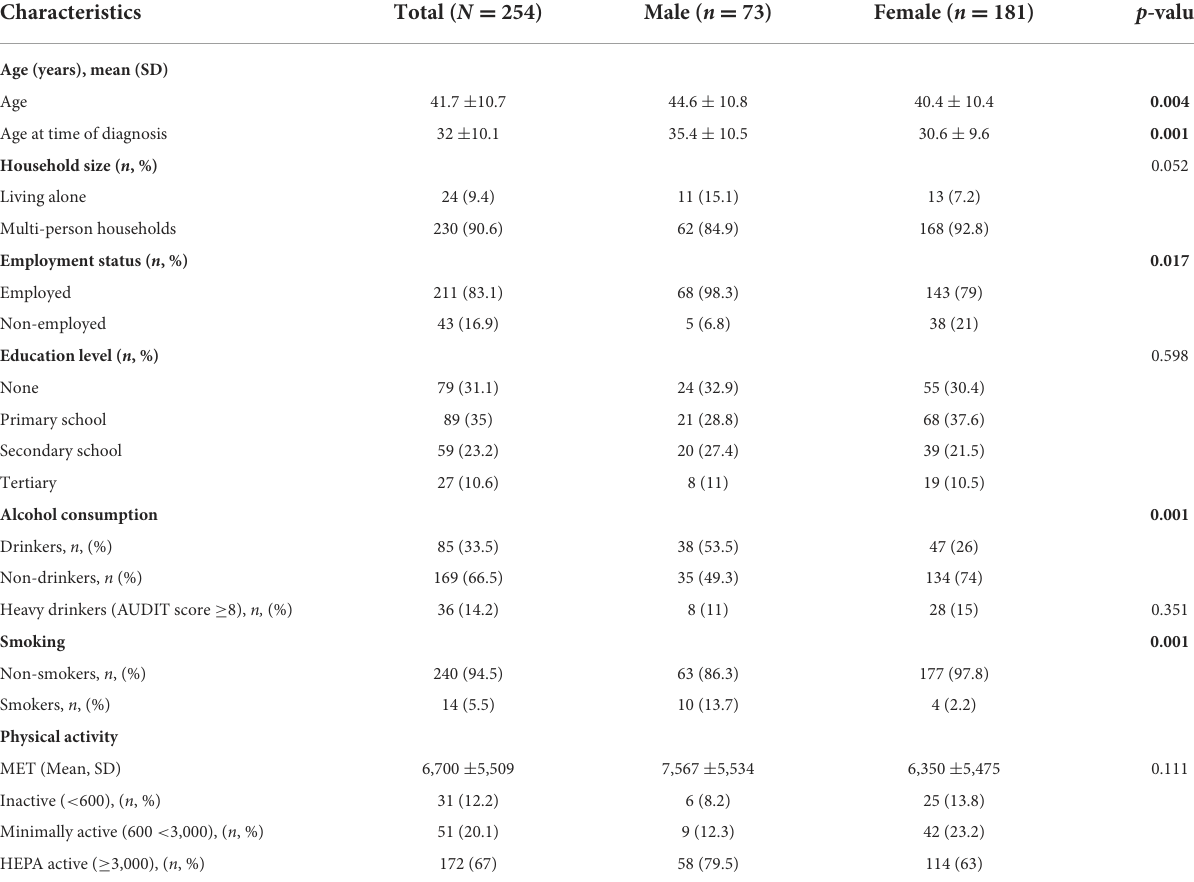
TABLE 1 Sociodemographic characteristics and CVD modifiable risk factors of study population.